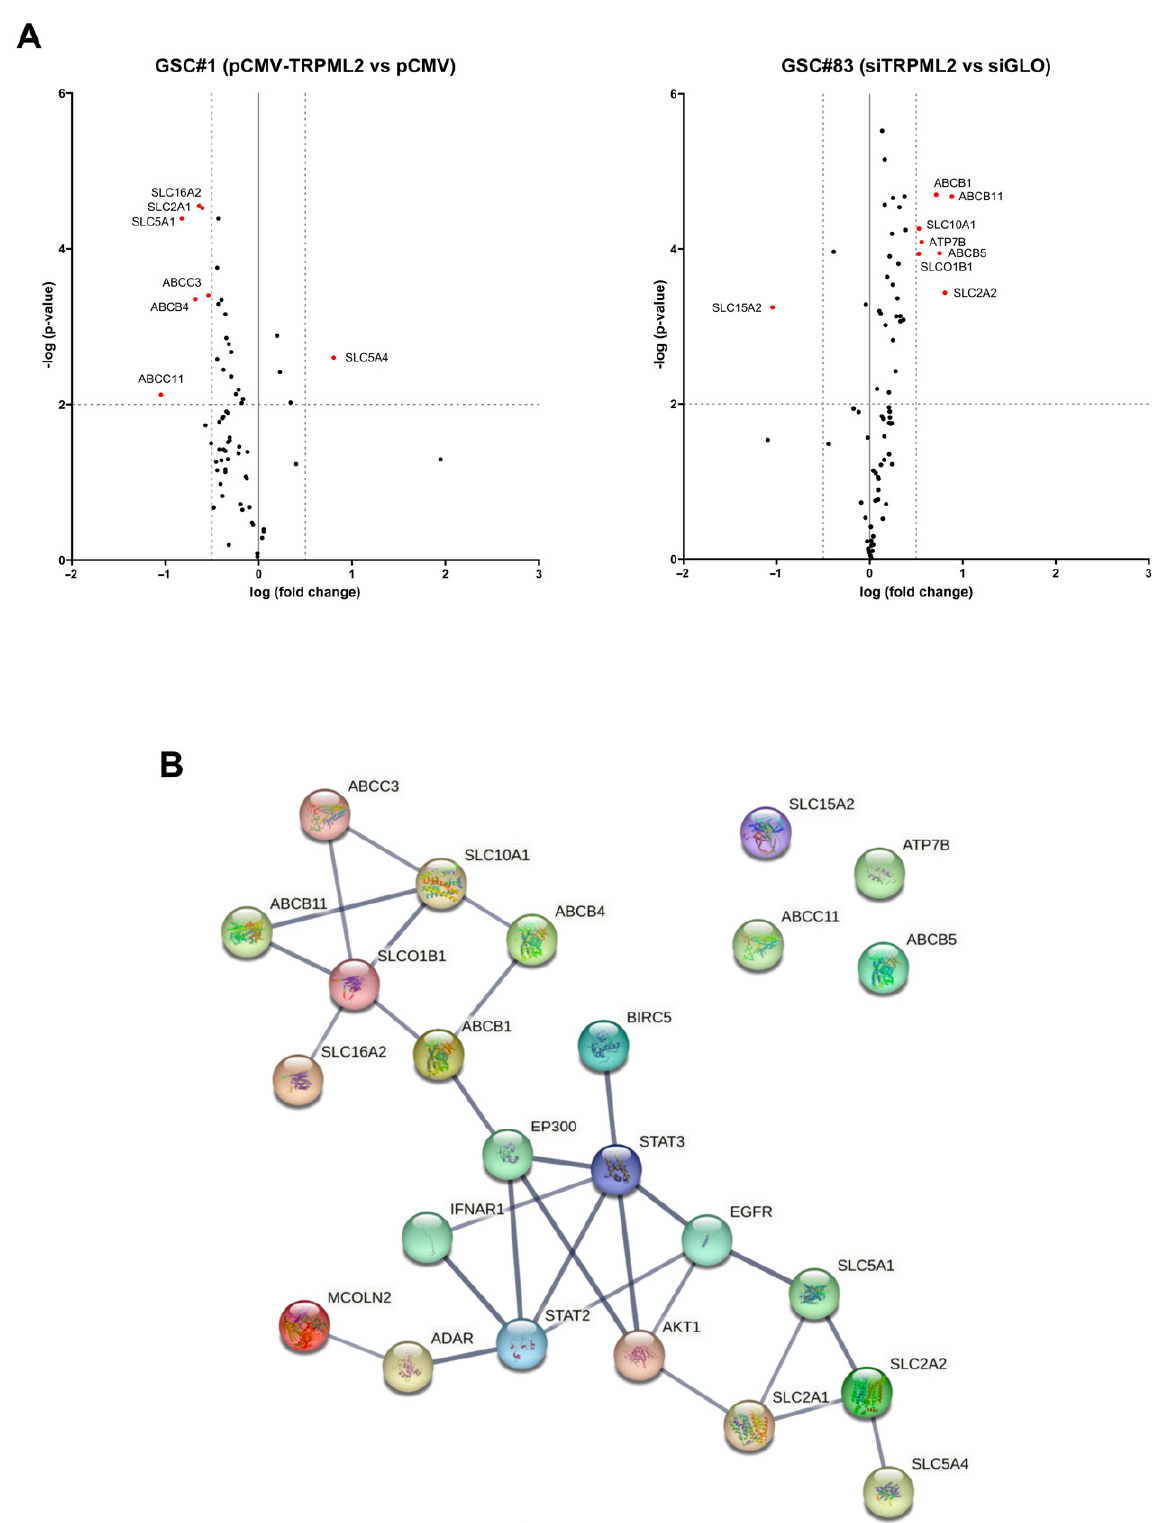
Figure 6. Differential expression analysis in GSC#83 and GSC#1 cell lines related to the degree of expression of TRPML2. ( A ) Volcano plot illustrates the relative expression levels for each gene depicted as log 10 (n-fold) plotted against –log 10 ( p -value) between (left) pCMV GSC#1 and pCMV- TRPML2 #1, and (right) siTRPML2 GSC#83 and siGLO GSC#83. Horizontal bar at y = 2